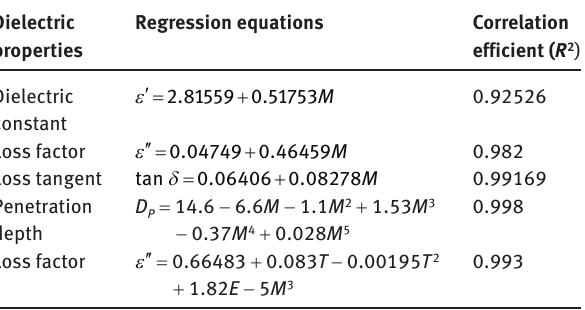
Table 3: Regression equations on moisture contents and dielectric